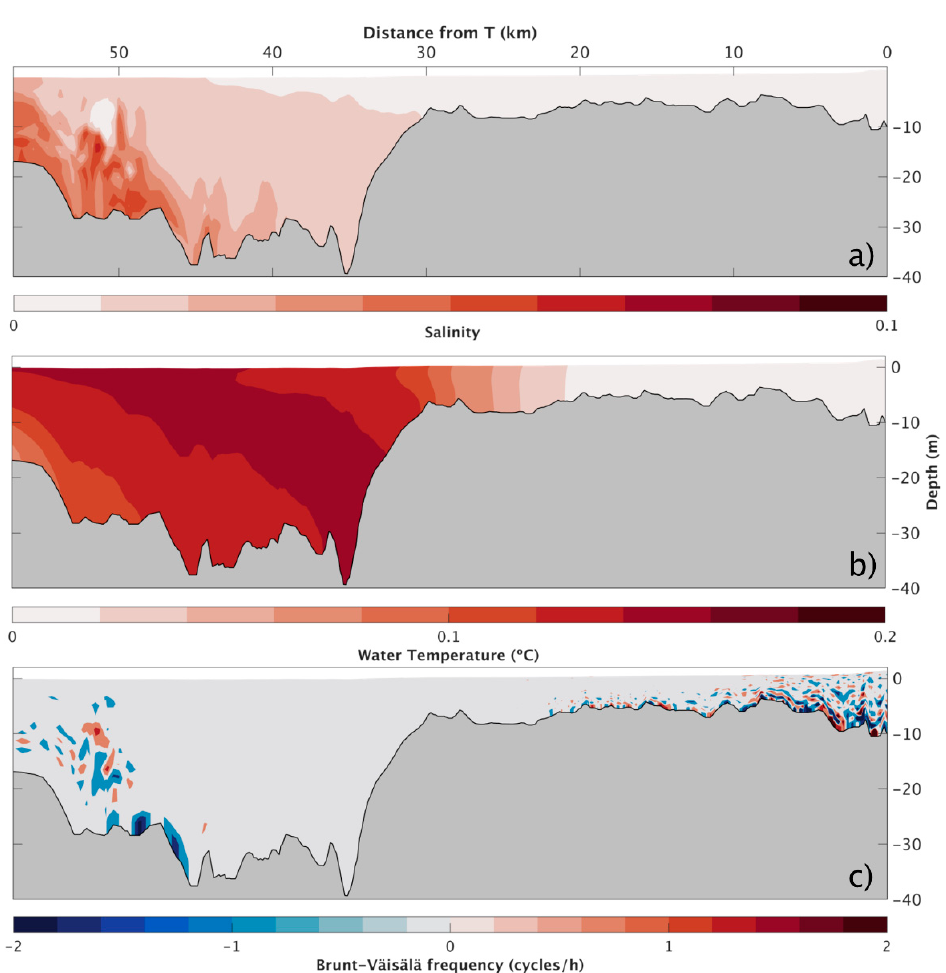
Figure 7. Vertical profiles along the longitudinal section of the estuary under increase of 1 °C of the air temperature. Difference between #Sc1 and #ScRef, in terms of ( a ) salinity; ( b ) water temperature; ( c ) Brunt–Väisälä frequency.